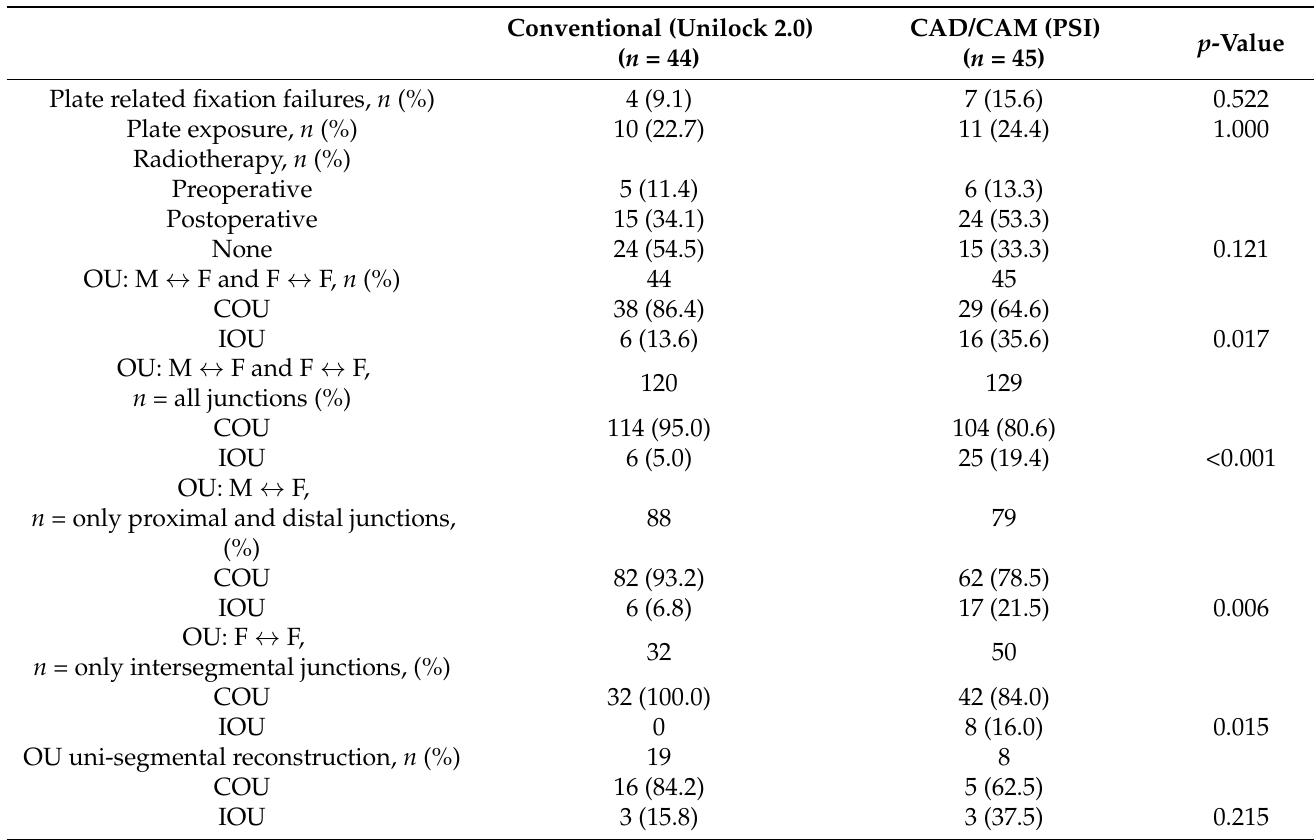
Table 2. Complication rates of the conventional vs. PSI groups. (FFF: free fibula flap; F: fibula; M: mandibula; PSI: patient-specific implant); IOU: incomplete osseous union; COU: complete osseous union; OU: osseous union. Note: In CAD/CAM-PSI group only n = 79 junctions in n = 45 patients were assessed, because eleven gaps were not interpretable by artifacts of the plate ( n = 1) and free ending without any contact to the origin mandible ( n =